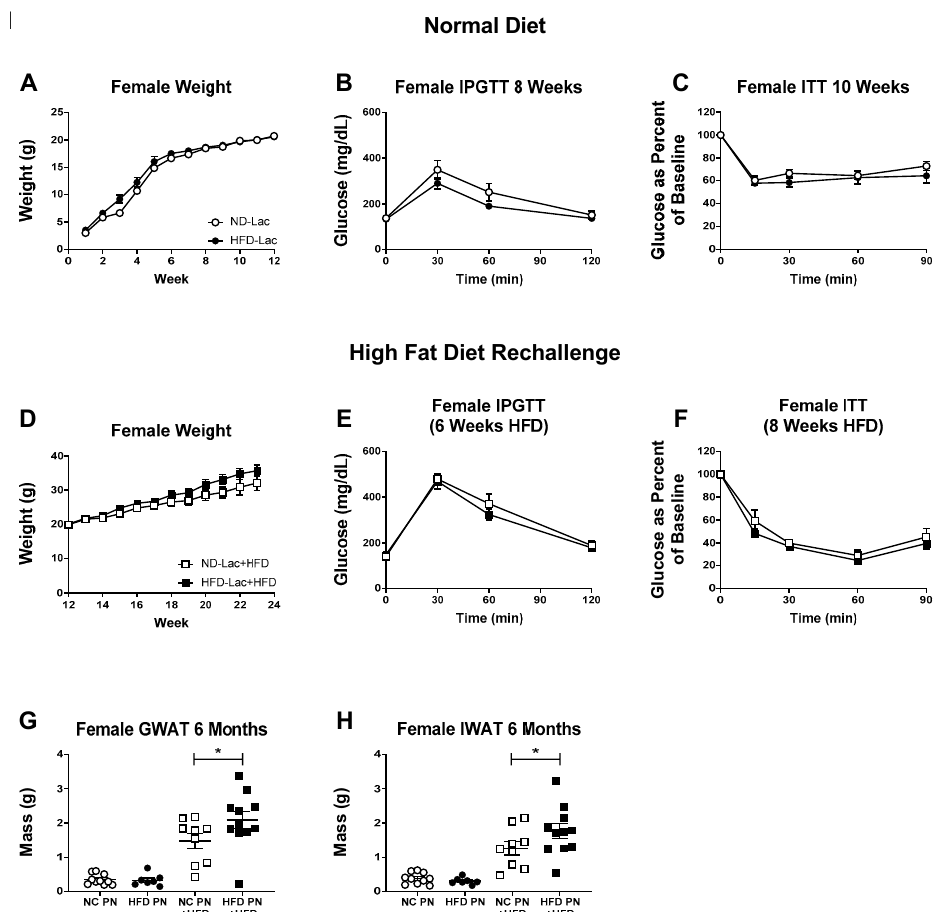
Figure 2. Female o ff spring had no evident metabolic programming after lactational HFD exposure. Analyzed experimental groups: ND-Lac (white circles), HFD-Lac (black circles), ND-Lac + HFD (white squares), HFD-Lac + HFD (black squares). Data collected from females maintained on a normal diet ( A – C ). Weekly weights ( A ). IPGTT at eight weeks, 6 h fast, 2 g / kg dextrose, ND-Lac n = 14, HFD-Lac n = 16 ( B ). ITT at 10 weeks, 6 h fast, 0.75 U / kg insulin, ND-Lac n = 10, HFD-Lac n = 9 ( C ). Data collected from females re-challenged with HFD at 12 weeks of age ( + HFD) ( D – F ). Weekly weights starting at the time of HFD feeding ( D ). IPGTT after six weeks of HFD feeding, 2 g / kg dextrose, ND-Lac + HFD n = 9, HFD-Lac + HFD n = 11 ( E ). ITT after eight weeks of HFD feeding, 1 U / kg insulin, ND-Lac + HFD n = 9, HFD-Lac + HFD n = 11 ( F ). Gonadal ( G ) or inguinal ( H ) white adipose depot weights collected at six months of age or after 12 weeks of HFD feeding. * p <